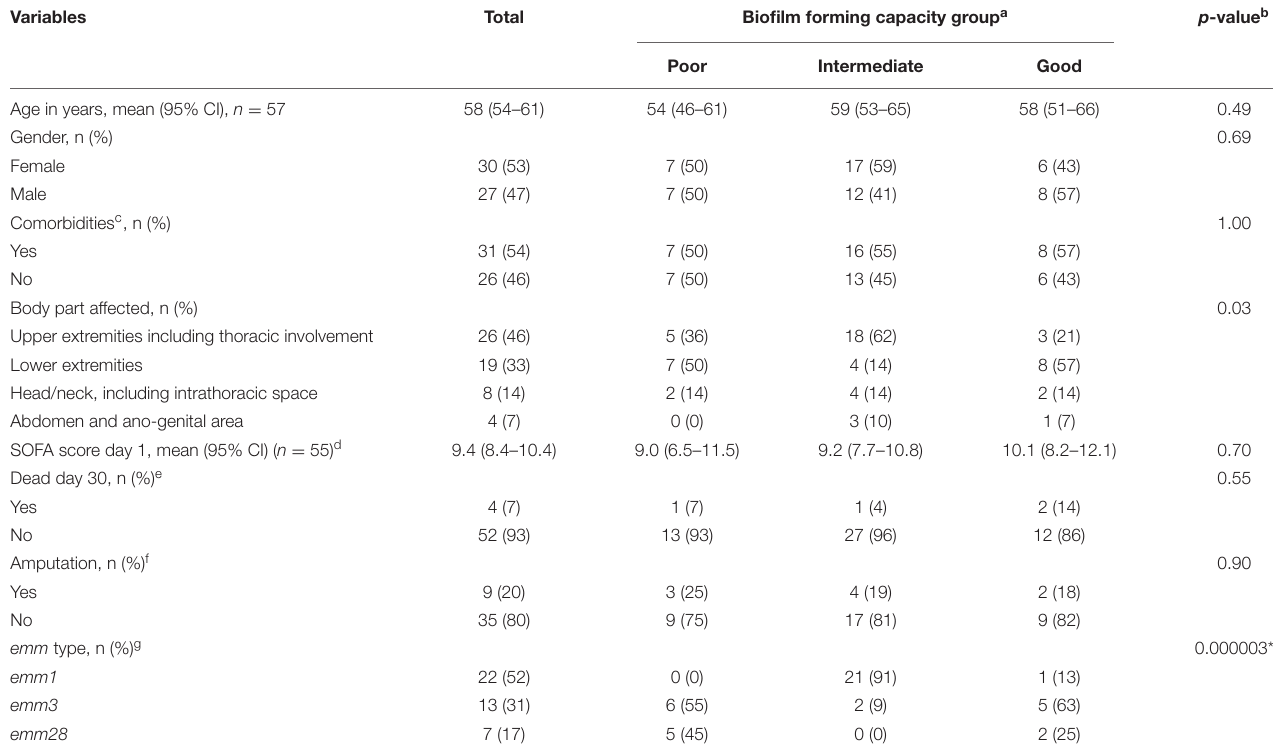
TABLE 1 | Biofilm forming capacity in relation to patient demographics, clinical variables and emm type.